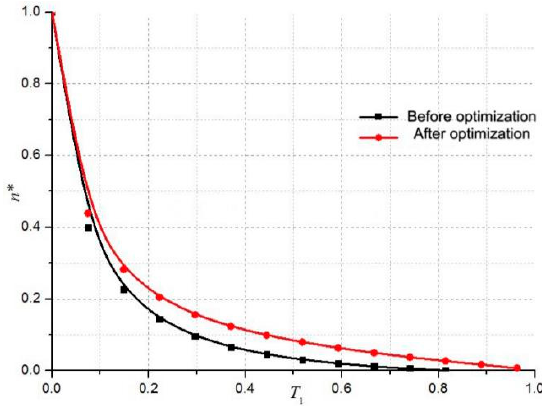
Figure 5. Change of rotational speed before and after the optimization of the nuclear reactor coolant pump during the coast-down transition process.